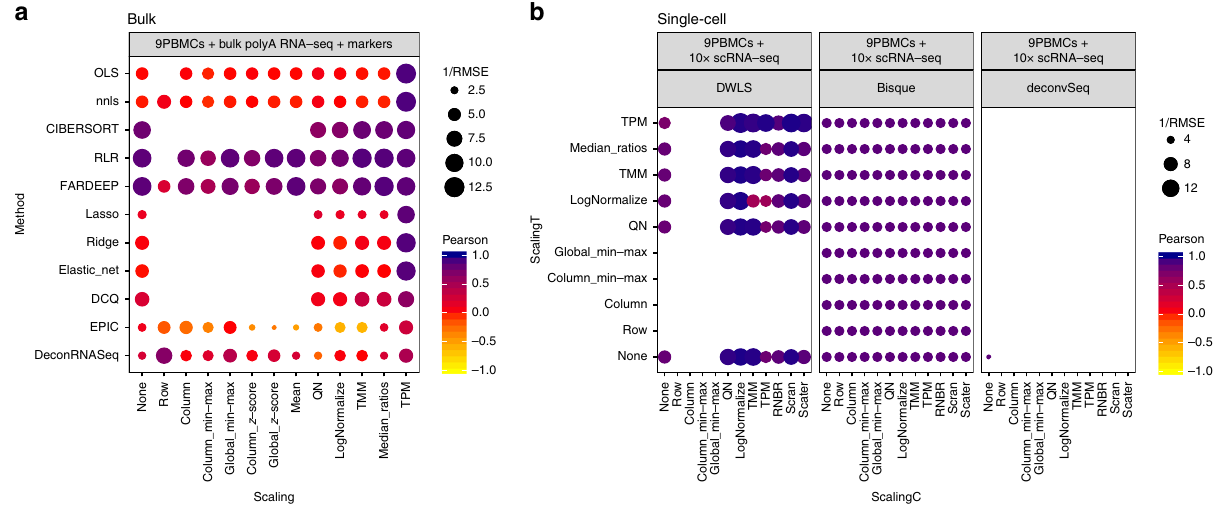
Fig. 7 Deconvolution performance on nine human PBMC bulk samples. With a bulk deconvolution methods; b deconvolution methods using scRNA-seq as